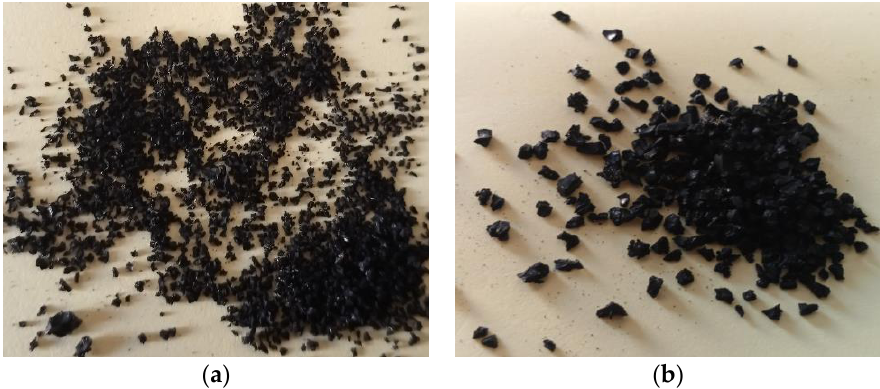
Figure 1. Ground tire rubber (GTR) aggregates used in this research: rubber powder ( a ) and rubber granules ( b ).